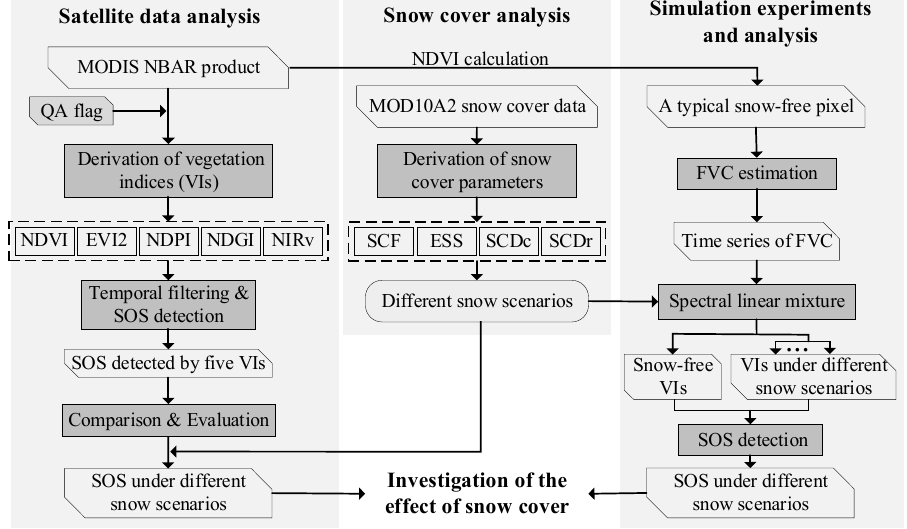
Figure 5. Flowchart of the investigation of the effect of snow cover on spring phenology detection.